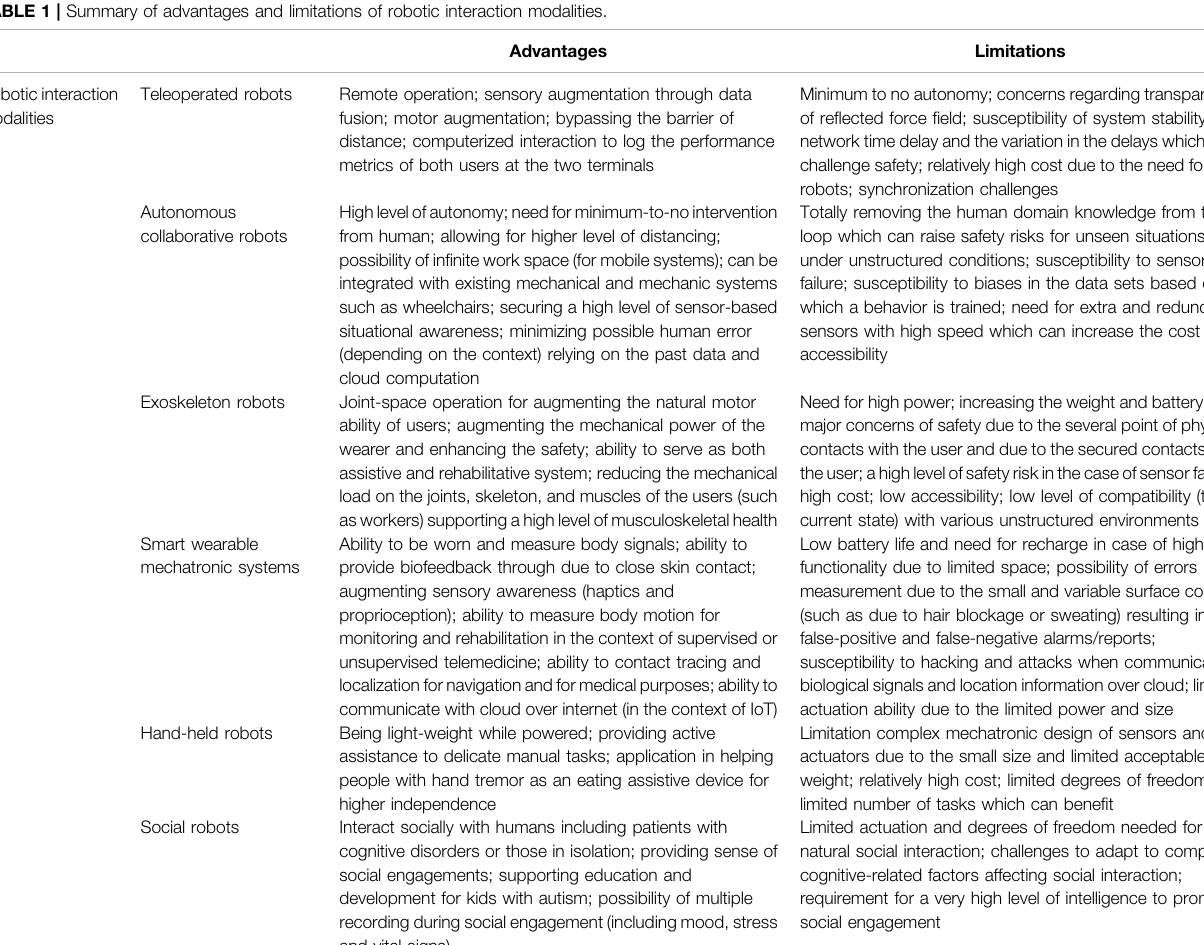
TABLE 1 | Summary of advantages and limitations of robotic interaction